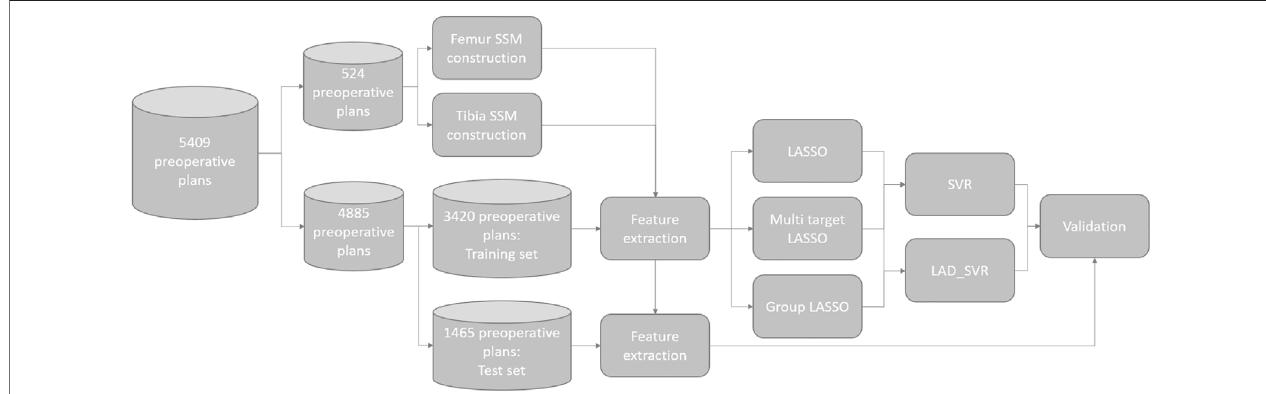
FIGURE 2 | A fl owchart of the dataset used for training and validation of the proposed